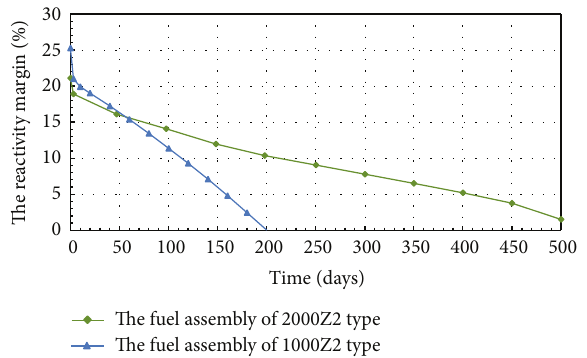
Figure 4: Change of the reactivity margin of HTGTR with fuel assemblies of 1000Z2 and 2000Z2 type.